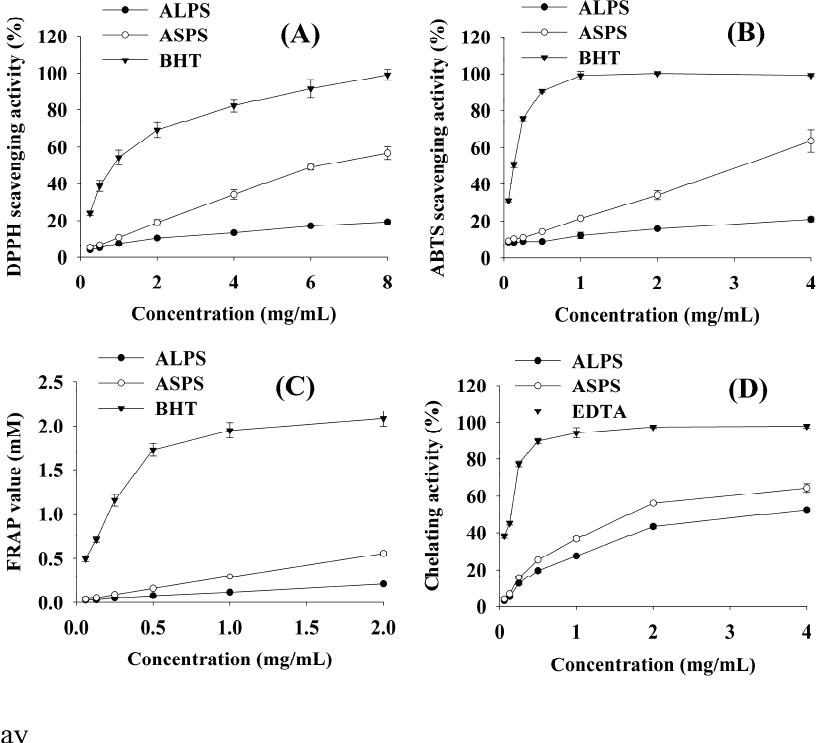
Figure 1. Antioxidant activities of ALPS and ASPS evaluated by the DPPH ( A ), ABTS ( B ), FRAP ( C ) and FIC ( D )